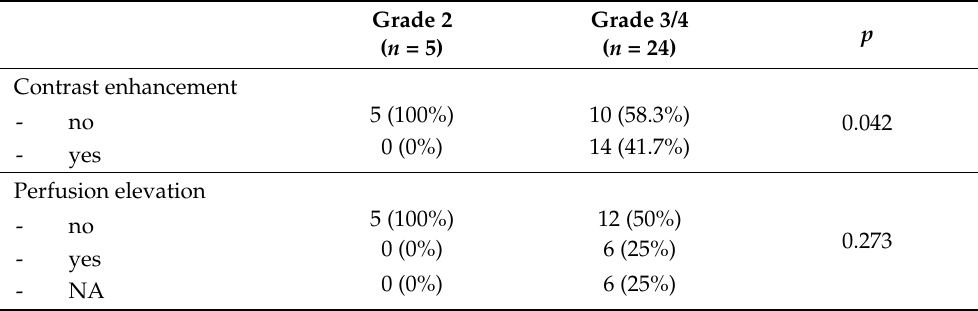
Table 3. The association of tumor grade with the presence of contrast enhancement and elevated rCBV (Fisher’s exact